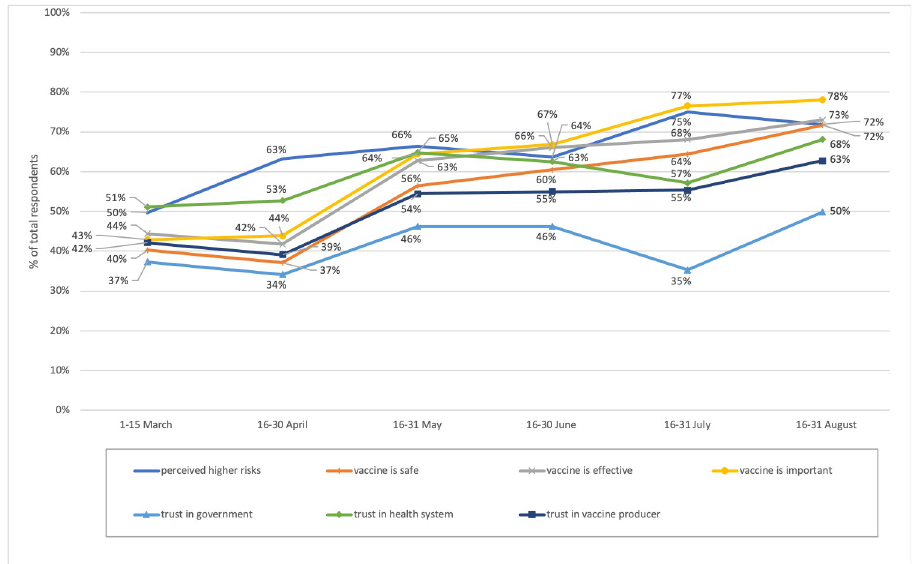
Fig 4. Trend of key parameters related to COVID-19 vaccine in the